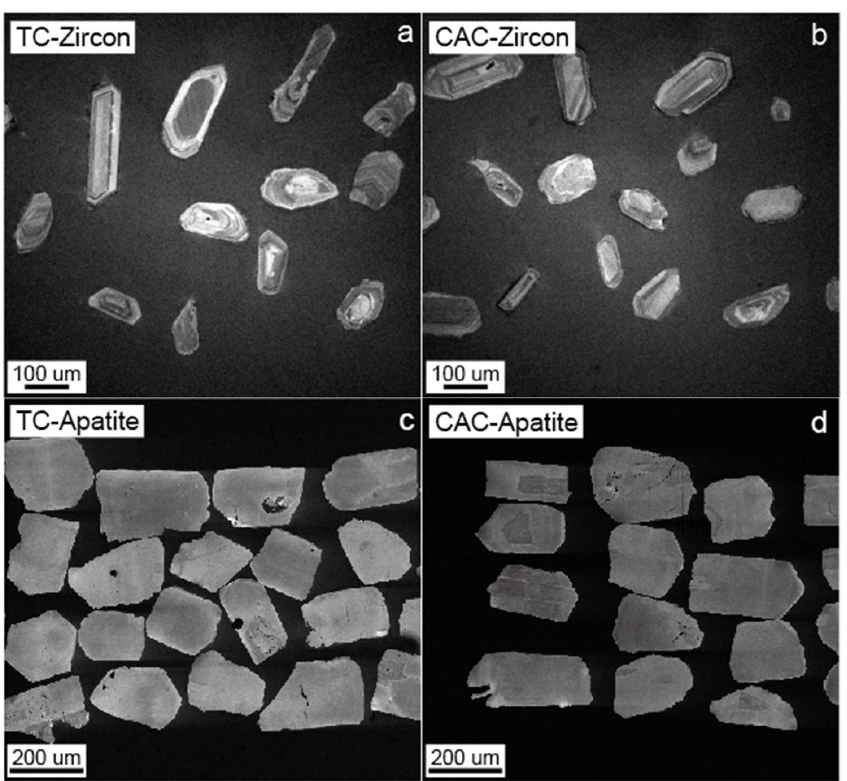
Figure 3. ( a , b ) Cathodoluminescence images of zircons from Tongchang and Chang’anchong quar tz syenite porphyries. ( c , d ) Backsca tt ered electron images of apatites from Tongchang and Chang’anchong quar tz syenite porphyries.